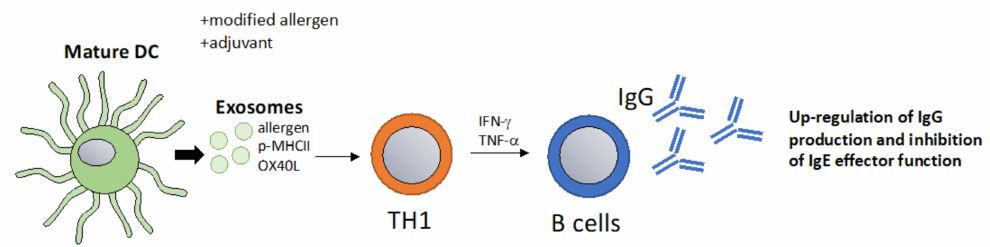
Figure 4. DC-derived exosomes as a vaccination approach that boost protective IgG responses. Exosomes derived from mature DCs pulsed with allergens promote T cell and B cell activation resulting in a classical TH1 type immune response with increased IgG titers [107]. High IgG titers inhibit IgE-mediated effector functions and thus allergic inflammation. This method could be optimized in multiple ways for example by the addition of specific adjuvants or by packaging allergens that are modified to be more